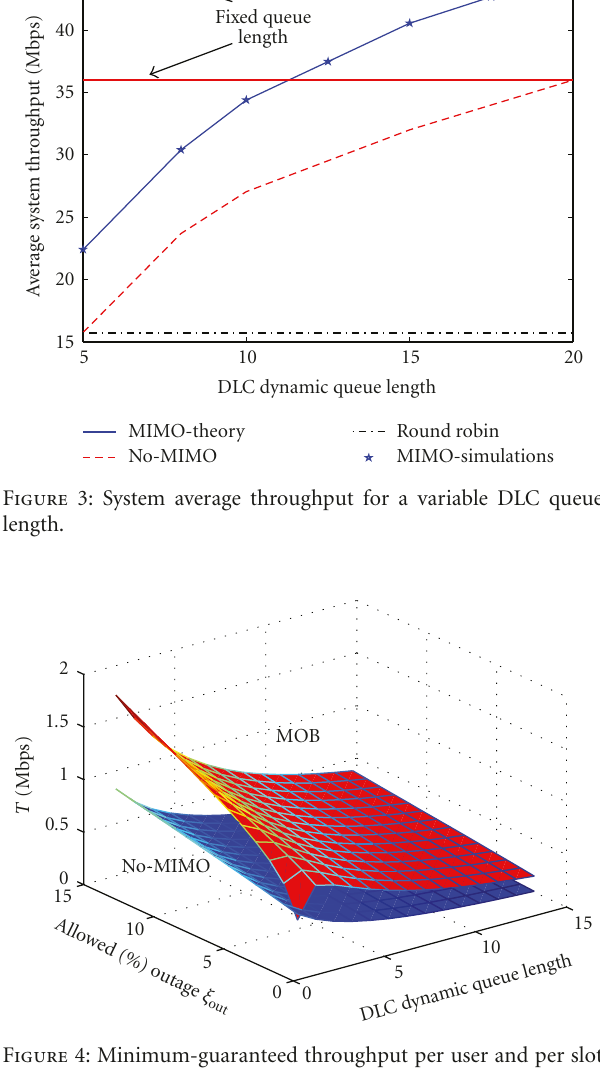
Figure 4: Minimum-guaranteed throughput per user and per slot for a variable DLC queue length and